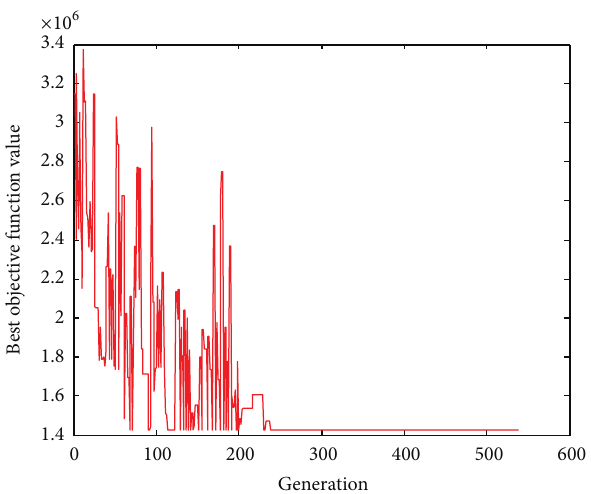
Figure 2: Trends of optimal objective function value by HGSAA.